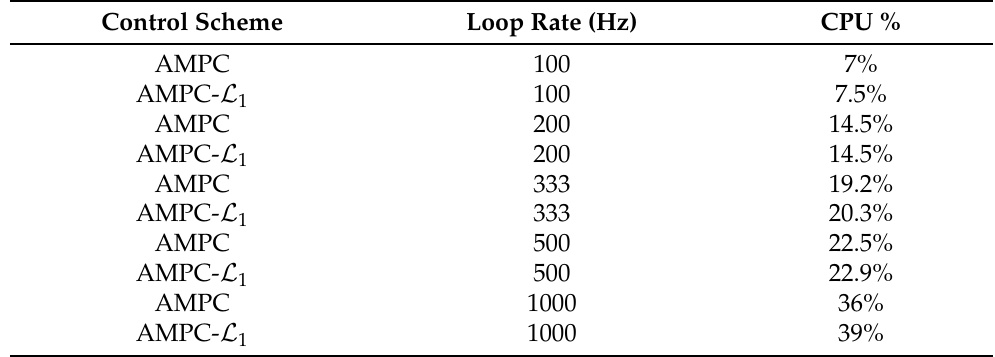
Table 7. Comparison of computational load on the Raspberry Pi at various loop update